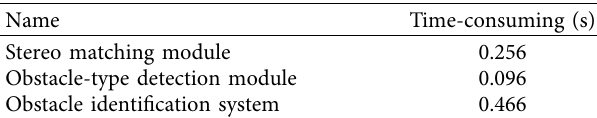
Table 7: Average system